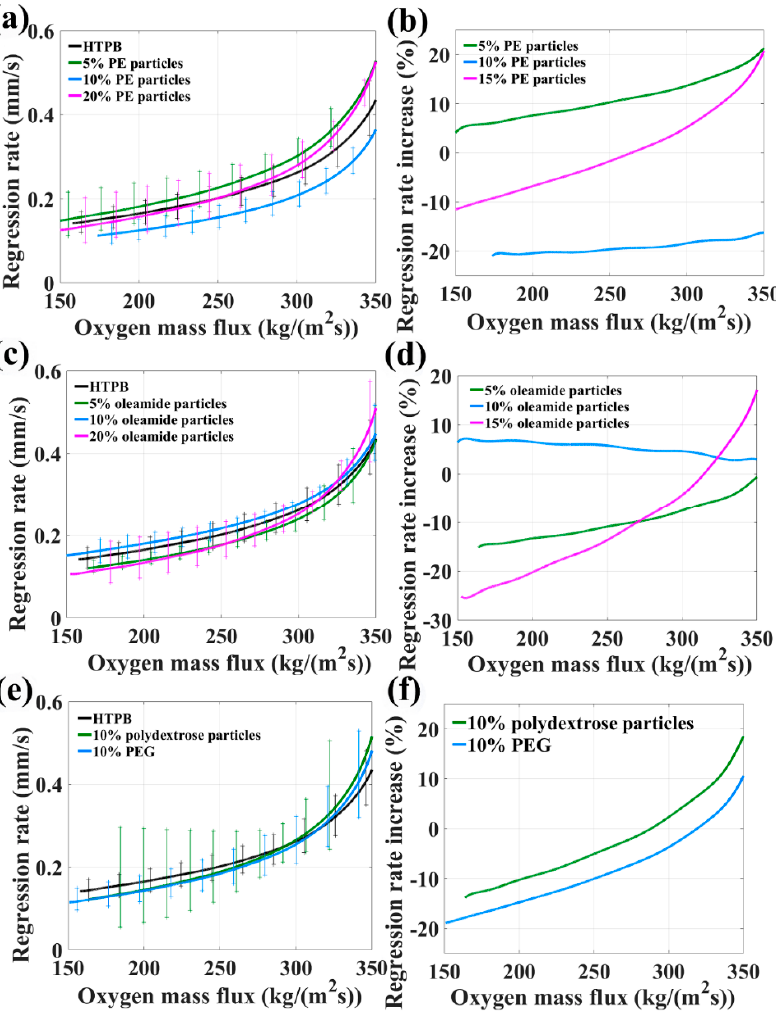
Figure 5. ( a , c , e ) Regression rate and ( b , d , f ) percent increase in regression rate vs. oxygen mass flux for low molecular mass polyethylene (PE paraffin) (5%, 10%, and 20%)/HTPB, oleamide (5%, 10%, and 20%)/HTPB, 10% polydextrose/HTPB, and 10% PEG6000/HTPB composite fuels, respectively.